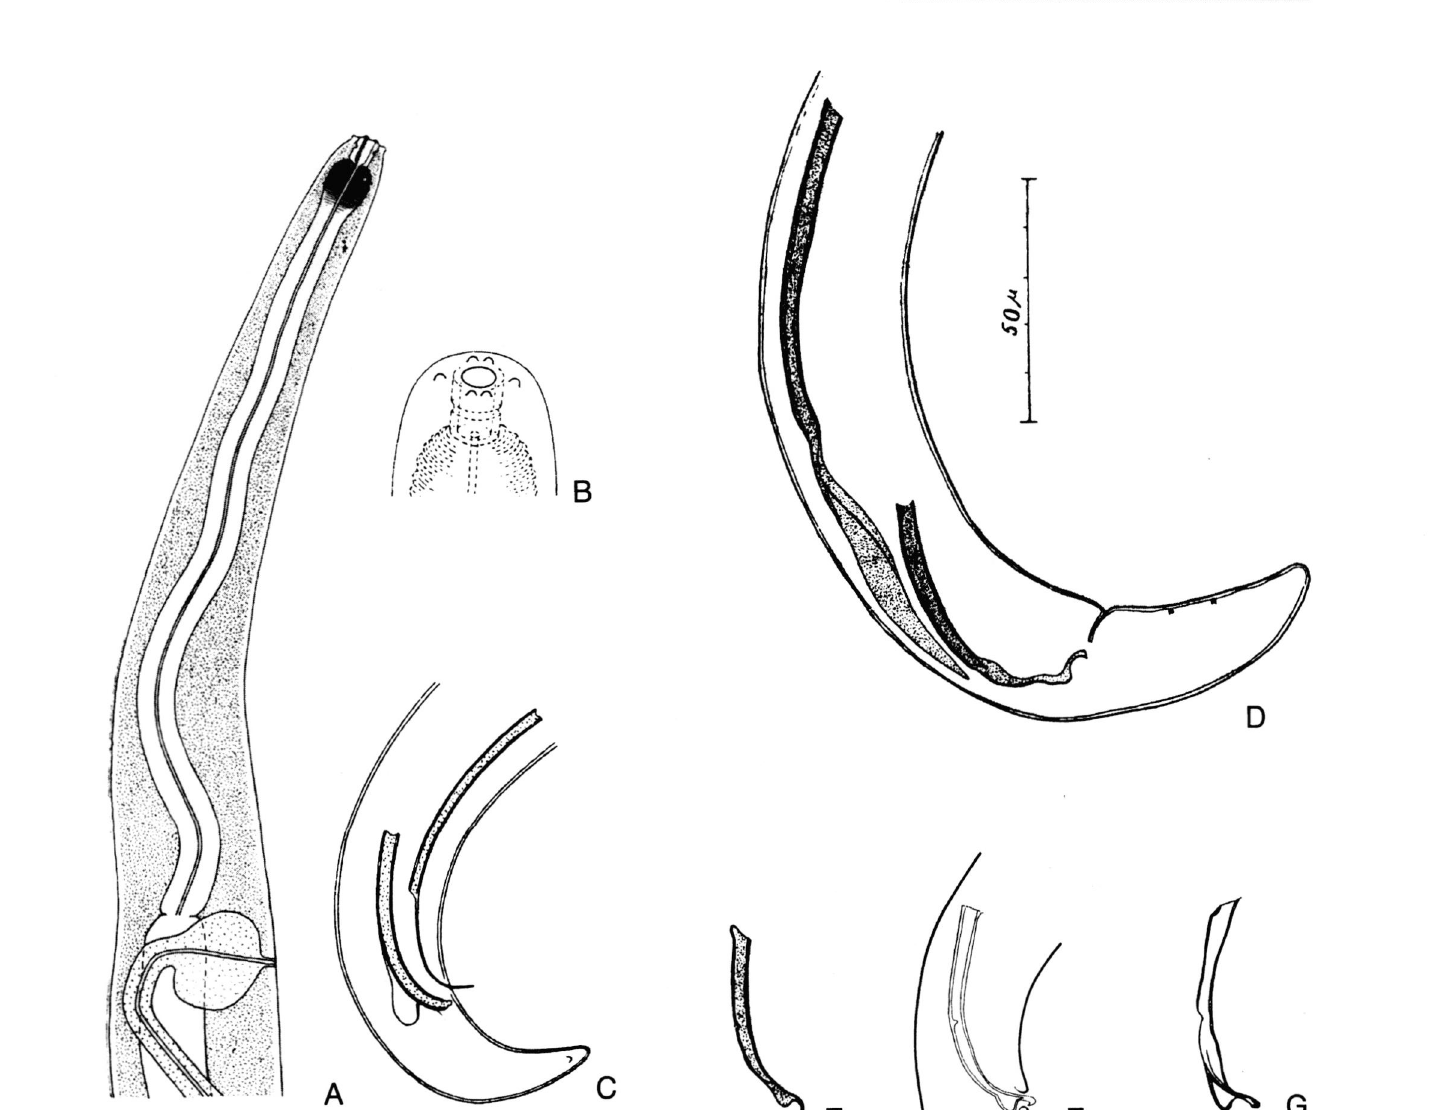
Fig. 3. - L- guiterasi, L. hamletti and L. chandleri, from published figures. A to C , L. guiterasi from Pérez Vigueras (1934). A, anterior region of female, right lateral view. B, head. C, male tail, right lateral view. D, L. hamletti from Sandground (1934), male caudal region. E, L. gui terasi. right spicule, from Sandground (1934). F. Right spicule of L. chandleri from Esslinger (1973). G. Right spicule of L. chandleri from Guerrero et al. (2002). Scale bar: D, 50 µm ; A. C, oesophagus and right spicule are 424 µm and 60 µm. respectively (Pérez Vigueras and Table III): E, F. G. right spicule is 60-65 µm